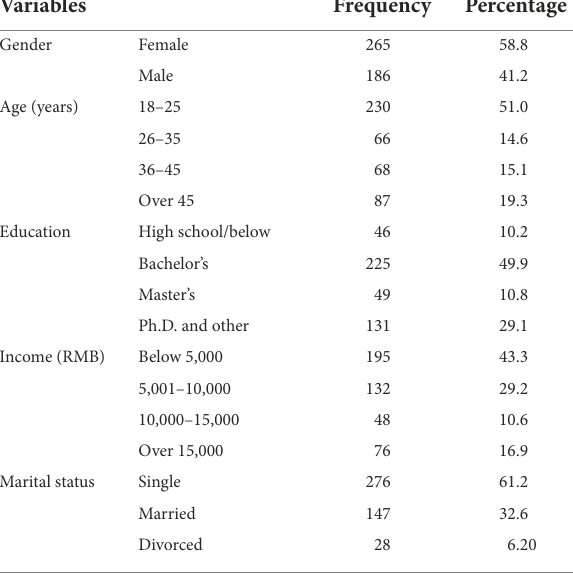
TABLE 1 Demographical information of